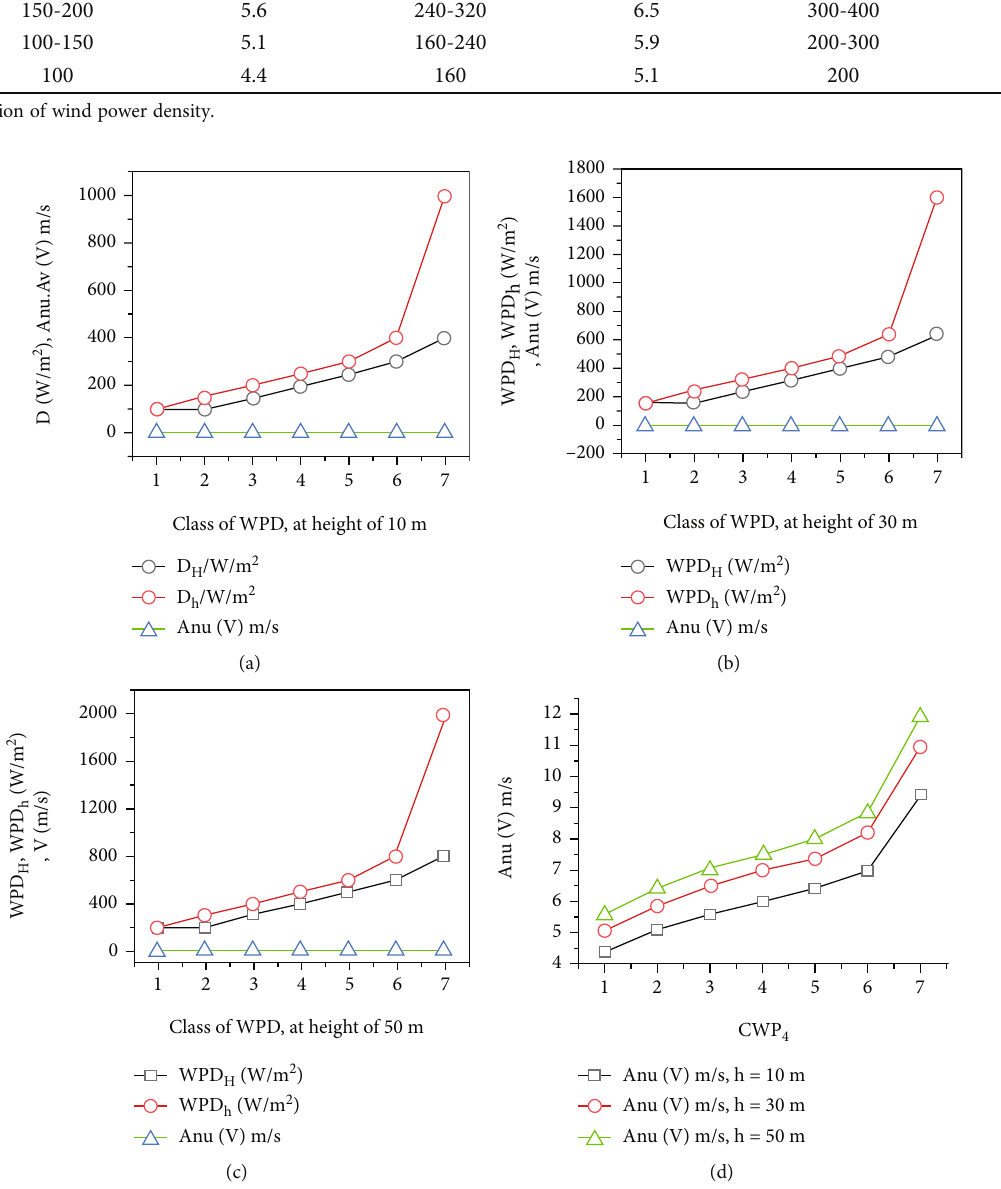
Figure 10: Wind power density and wind speed at di ff erent heights: (a) H = 10 m , (b) H = 30m , and (c) H = 50 m , (d) Class of wind power density vs. annual (V)